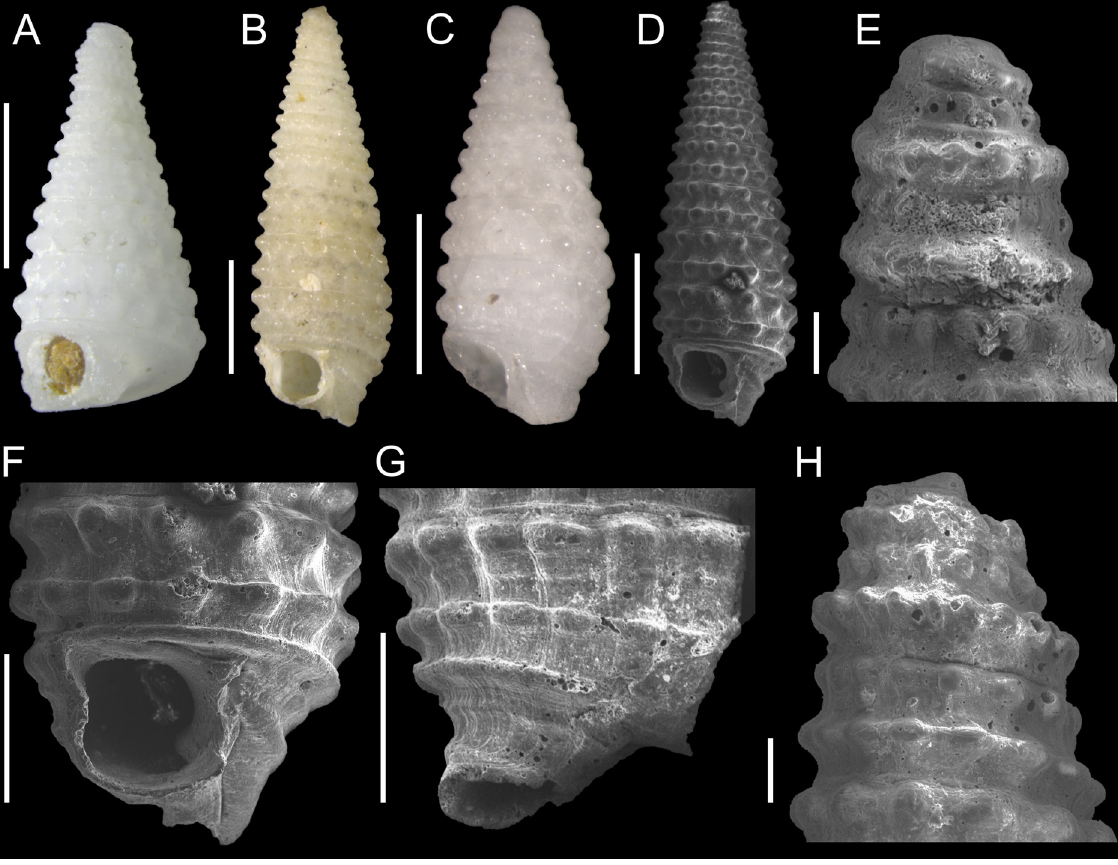
Fig. 4. Isotriphora uncia sp. nov. A . IBUFRJ 11165, holotype, 2.37 mm. B . MORG 24622*, 3.63 mm. C . MORG 19137*, 2.50 mm. D, F–H . Same shell as A. E . MORG 20632*. Scale bars: A–D = 1 mm; E, H = 100 µm; F–G = 500